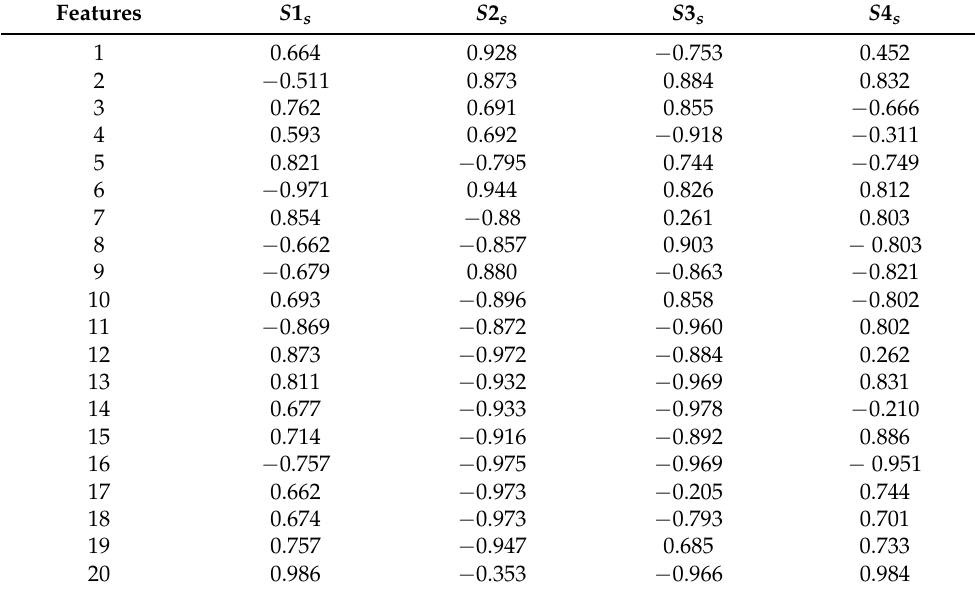
Table 3. Spearman correlation coefficient, S s , between autoencoder-extracted features and tool wear values.